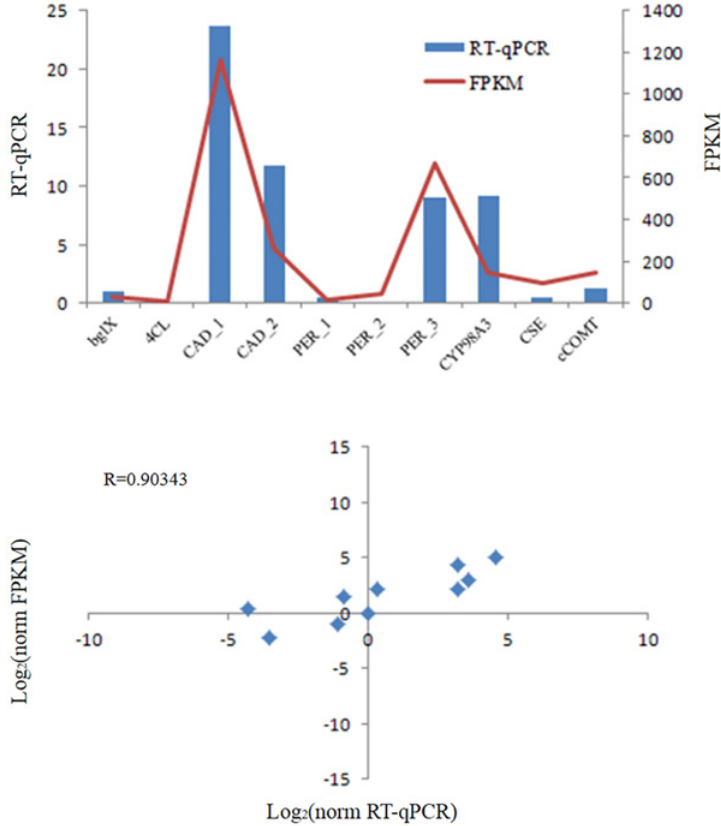
Fig 4. RT-qPCR analysis. Real-time PCR results for 10 selected genes related to lignin biosynthesis pathway. Plot in the top panel of the figure presents RNA-seq (line graph) and qPCR (bar graph) quantification results, and the bottom panel shows their high correlations (r > 0.9). Corresponding gene names and unique gene identifier numbers in the assembly are bglX (comp10579_c0), 4CL